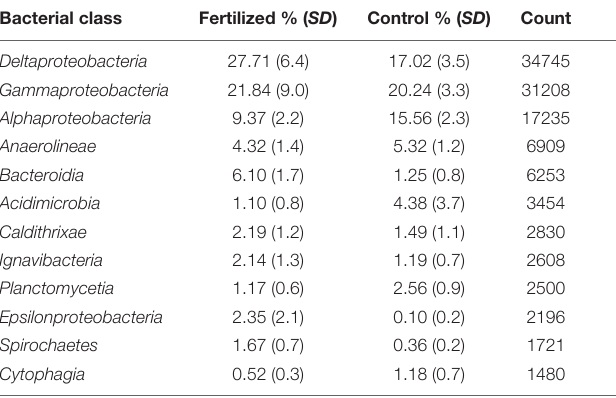
TABLE 2 | Bacterial classes that each accounted for > 1% of the potentially active community (based on 16S rRNA), the percentage of the community they represent in fertilized (XF and HF) and control communities, and their sum counts in the rarified dataset. Bacterial class Fertilized % ( SD )